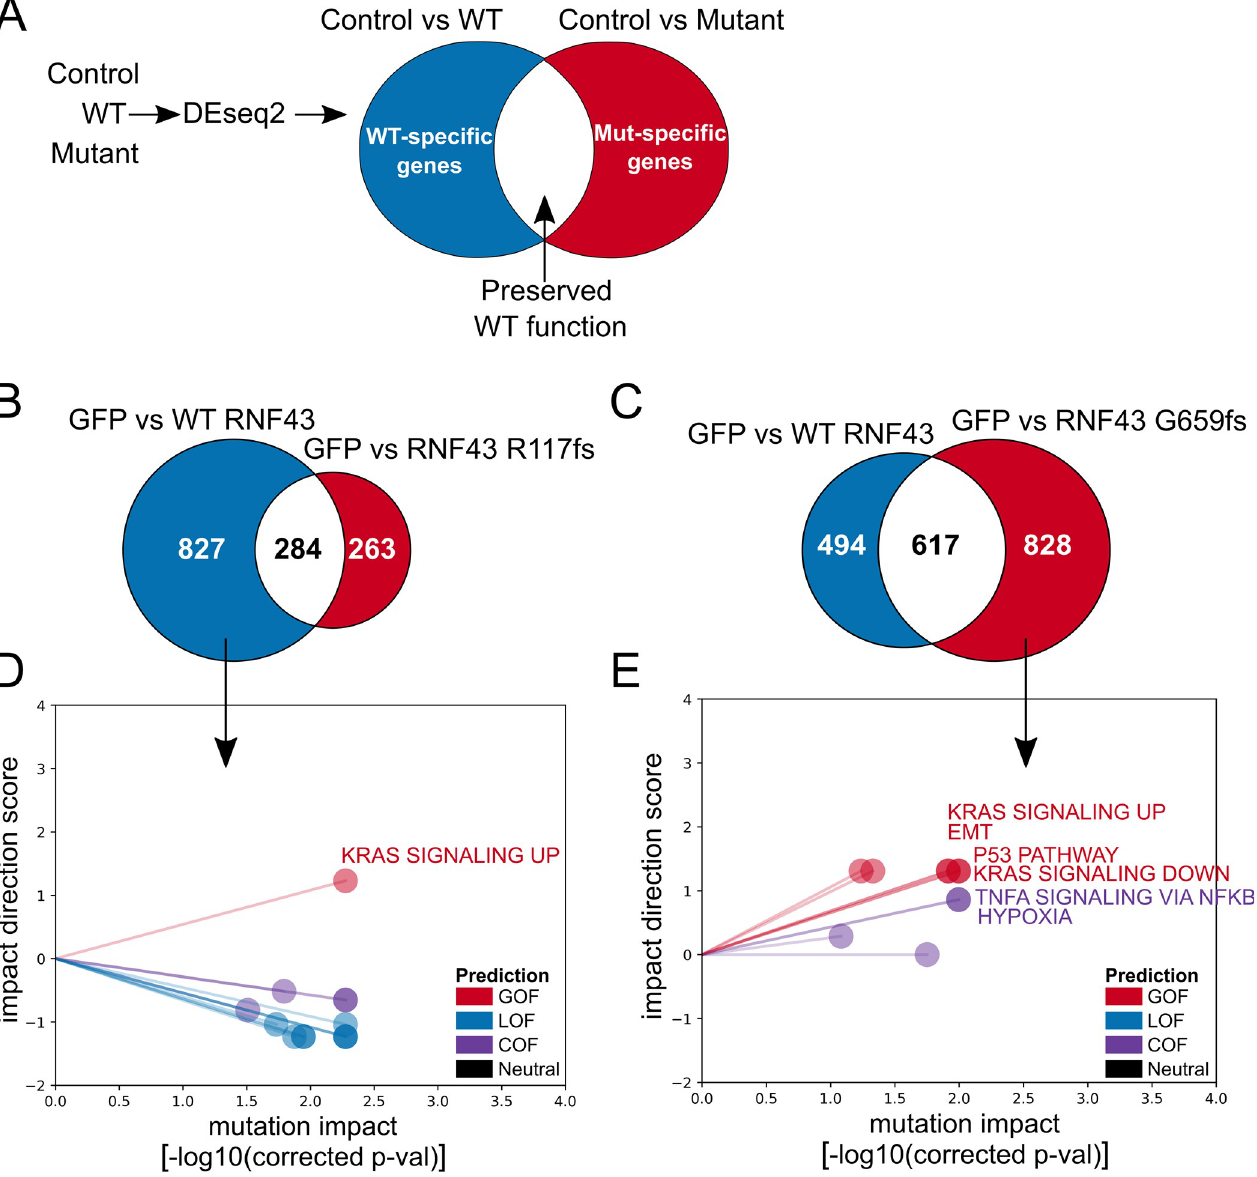
Fig 3. eVIP mutation-specific and WT-specific pathway analysis for LOF RNF43 R117fs and COF RNF43 G659fs . (A) Overview of method to identify WT- specific (blue) and mutation-specific (red) differentially expressed genes using DESeq2 (B) RNF43 R117fs: Count of RNF43 WT-specific genes (blue) and RNF43 R117fs mutation-specific genes(red) (C) RNF43 G659fs: Count of RNF43 WT-specific genes (blue) and RNF43 G659fs mutation-specific genes(red) (D) Sparkler plot representation of eVIP Pathway results on RNF43 R117fs WT-specific genes (E) Sparkler plot representation of eVIP Pathway results on RNF43 G659fs mutation-specific